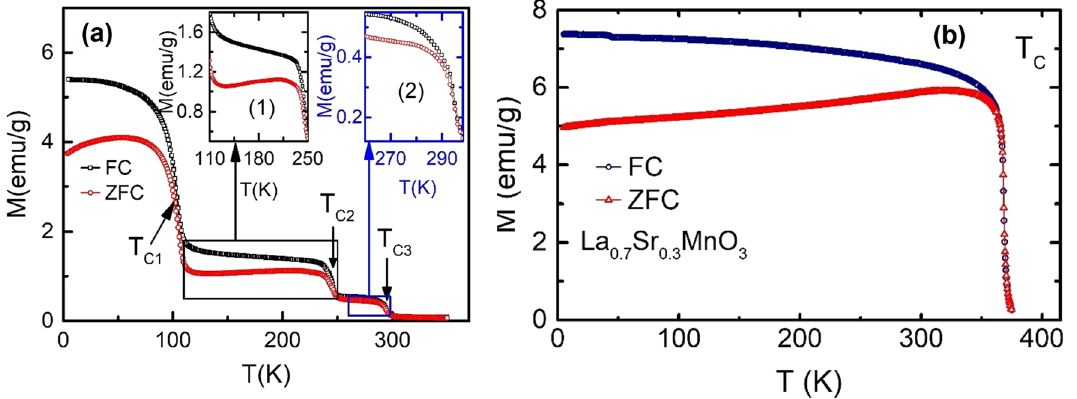
Figure 3. ( a ) FC and ZFC for BL-LSMO-0.3 in the temperature range 5–350 K, which shows bifurcation around all the three transitions. Inset (1) and (2) are the expanded view of FC and ZFC for T C 1 < T < T C 2 and T C 2 < T < T C 3 to see the clear bifurcation around T C 2 and T C 3 , respectively. ( b ) FC and ZFC for IL-LSMO-0.3 in the temperature range 5–380 K, which shows the overlapping of FC and ZFC around and above transition.